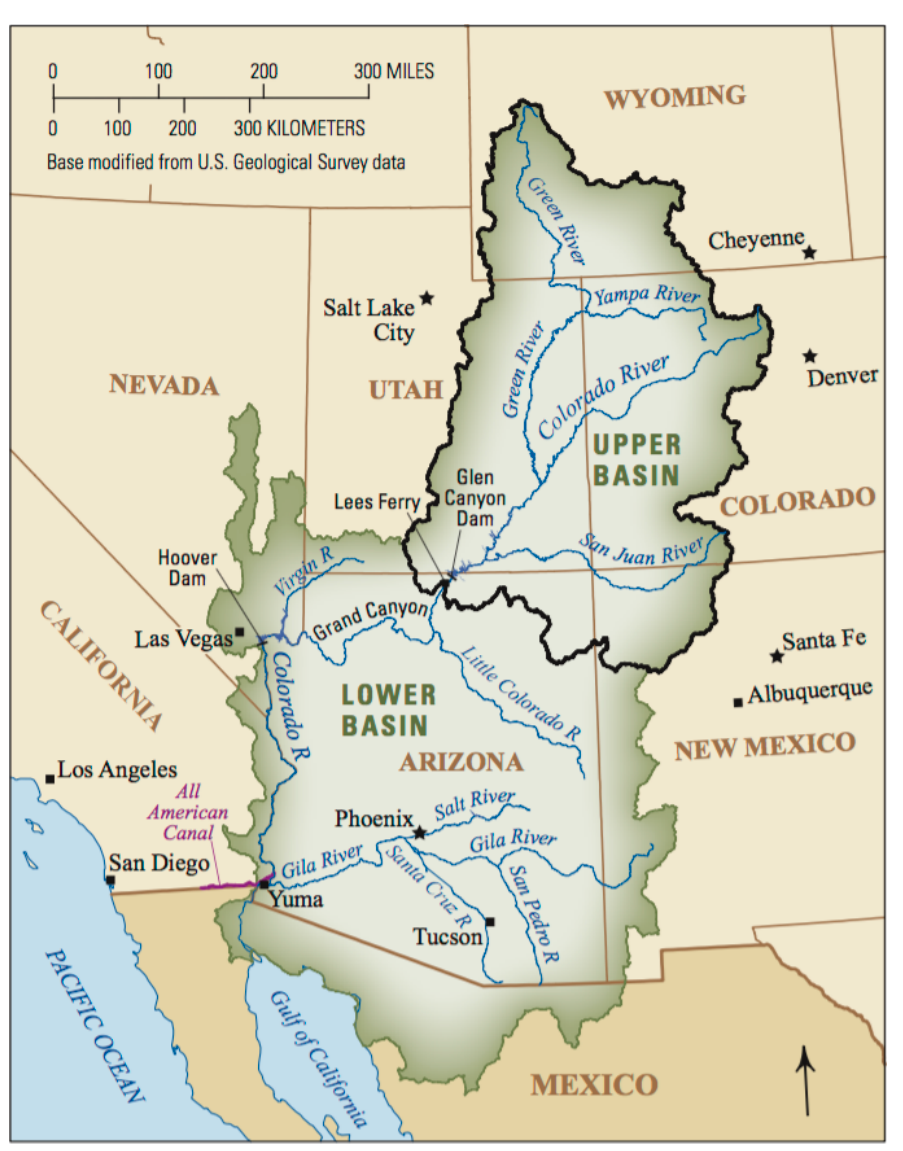
Figure 1. Drainage basin of the Colorado River in the Southwestern United States and Mexico (Public domain image from